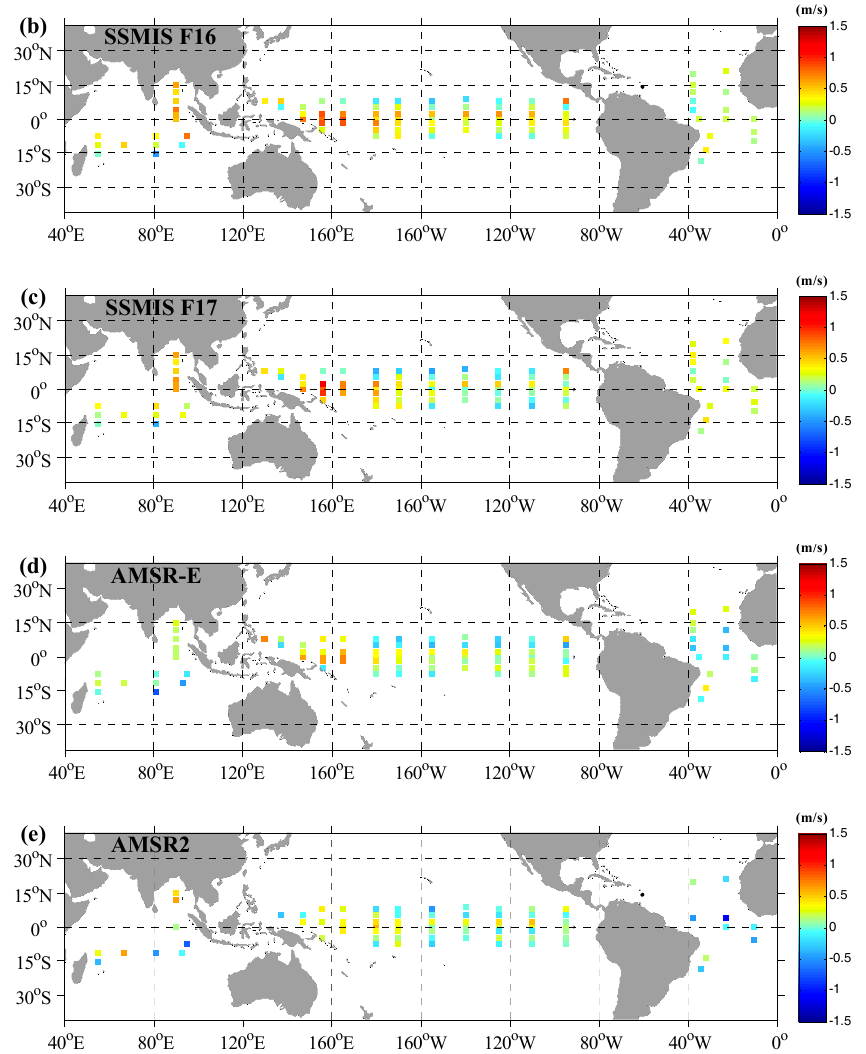
Figure 3. The mean difference (denoted by the color of each box) of wind speeds between satellite and buoy at each buoy site: ( a ) WindSat; ( b ) SSMIS F16; ( c ) SSMIS F17; ( d ) AMSR-E; and ( e ) AMSR-2.